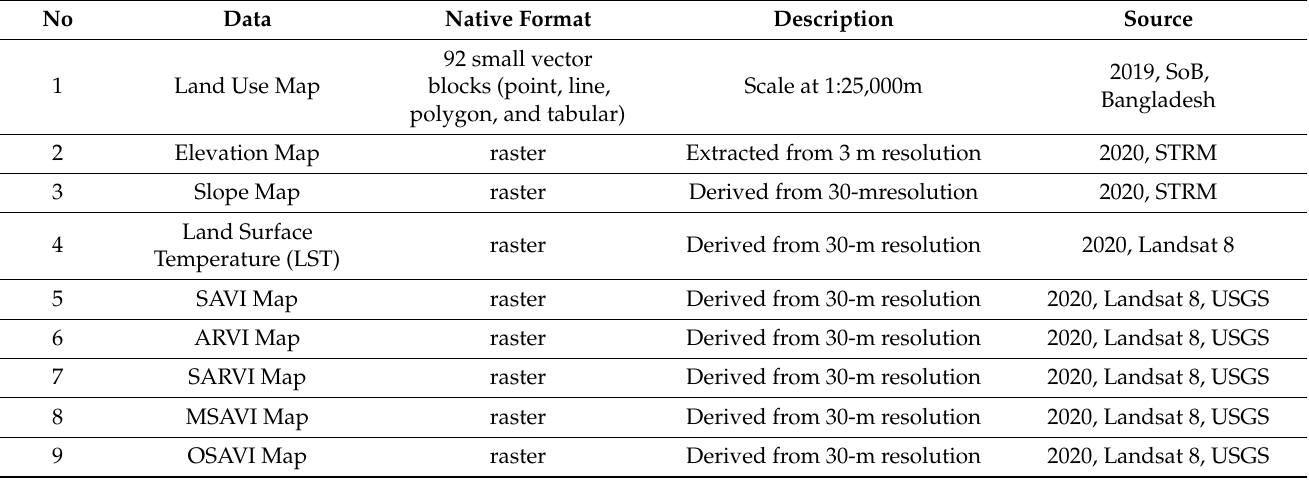
Table 1. List of data and original data sources for land suitability